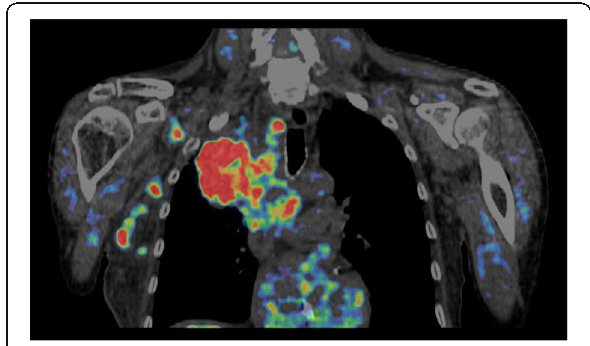
Fig. 1 An example coronal FMISO PET image fused with the corresponding CT displayed on a tumor to blood ratio (TBR) color scale. Red regions depict a TBR > 1.4 indicating hypoxia, and no visible PET depicts a TBR < 1, indicating normoxia